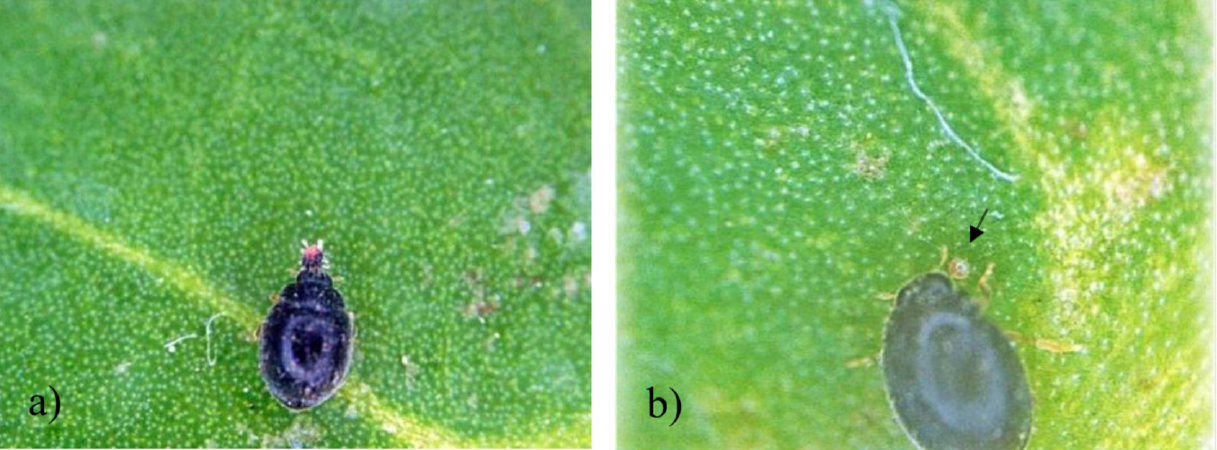
Figure 3. The specialist mite predator Stethorus gilvifrons coping with the web of the avocado brown mite, Oligonychus punicae : ( a ) predator feeding on female mite outside the web; ( b ) predator cutting web threads over the egg. Arrow indicates eggs covered with web threads.